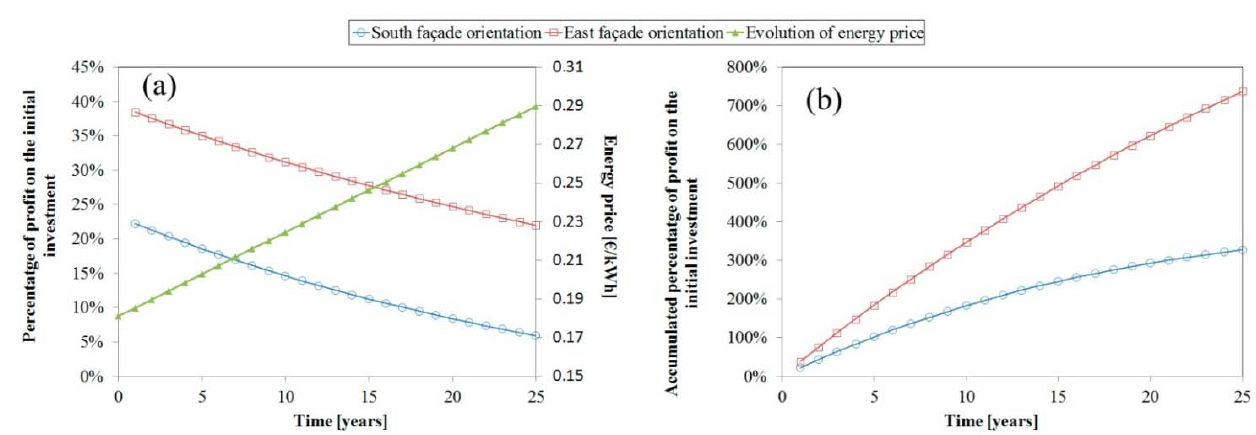
Figure 10. Percentage of profit on the initial investment during a 25 years horizon. ( a ) Yearly economic profit and evolution of energy price; ( b ) Aggregated economic